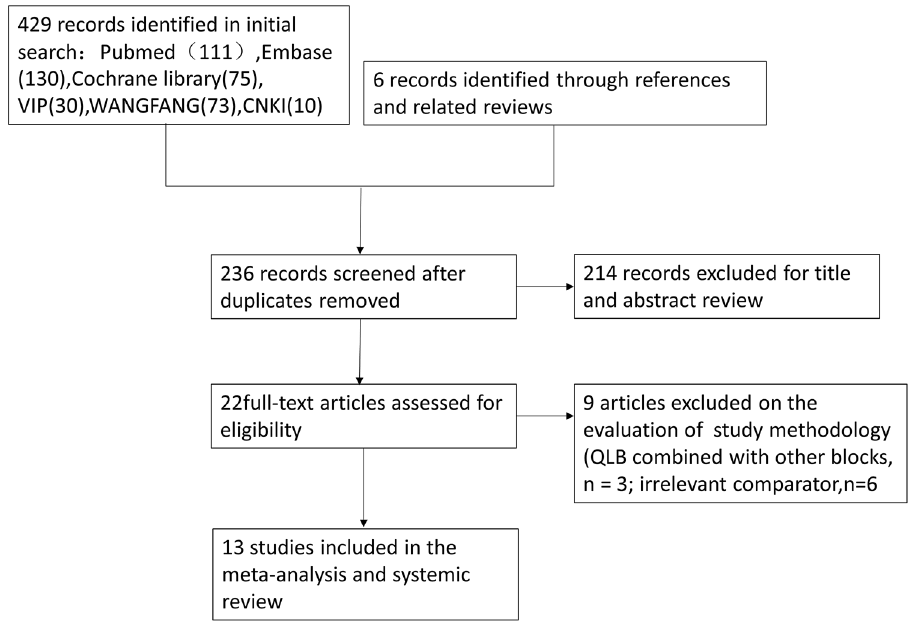
Figure 1. The flow diagram of the